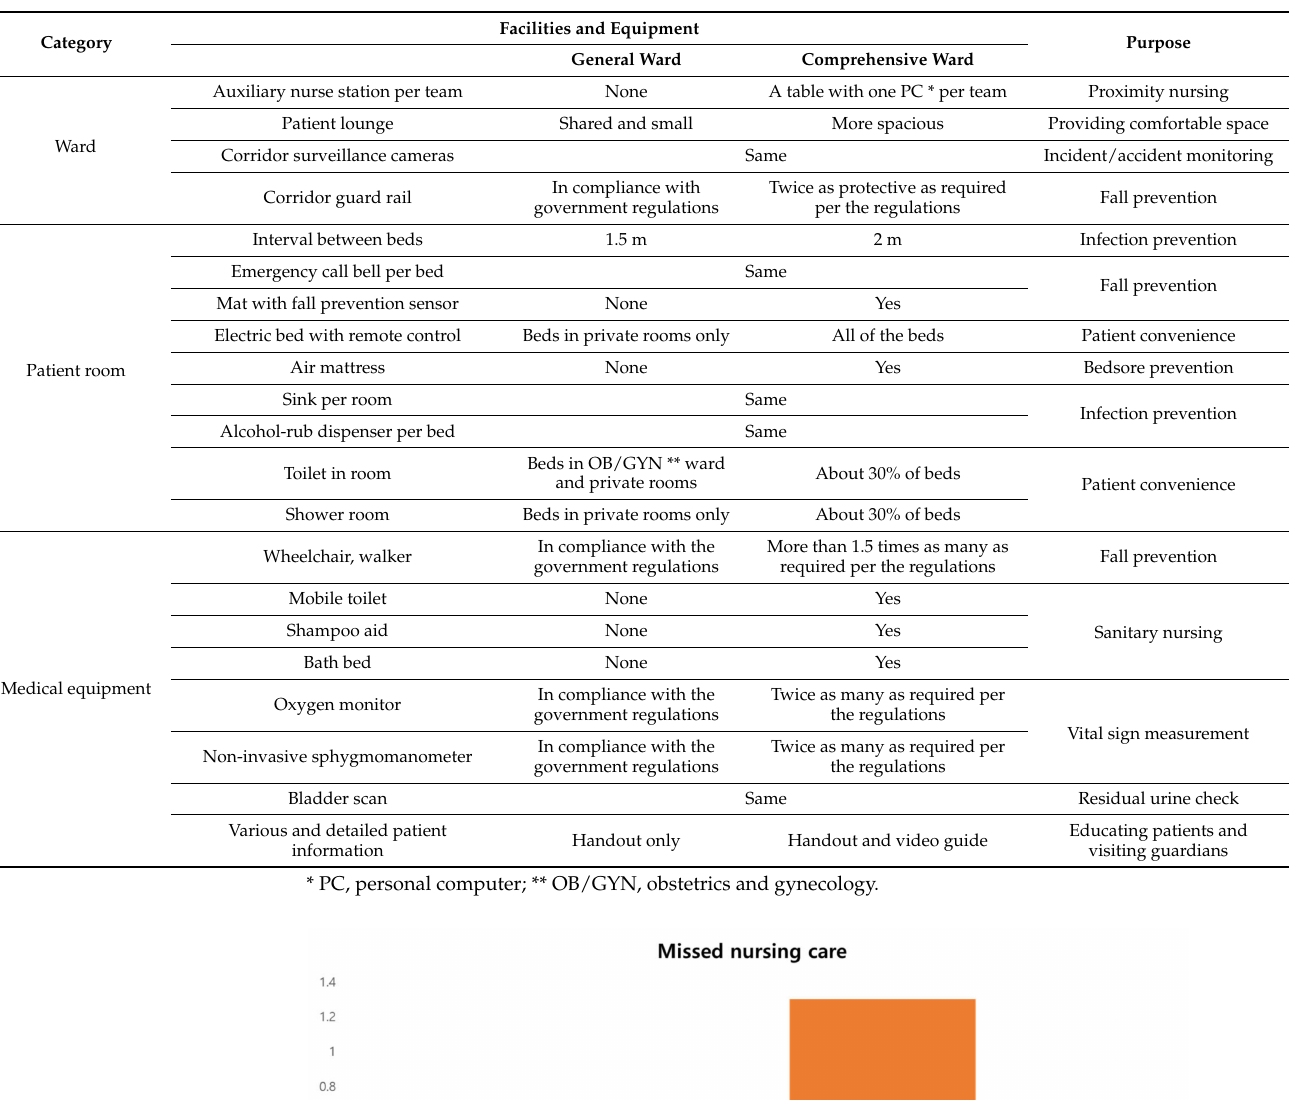
Table 1. The environmental improvements in the comprehensive nursing ward.